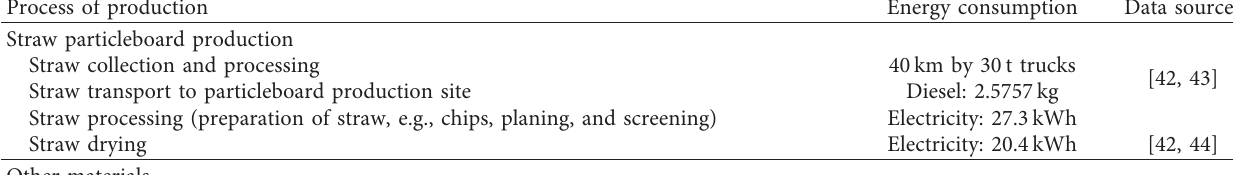
Table 1: LCI data for production of 1 m 3 straw particleboard and wood particleboard.